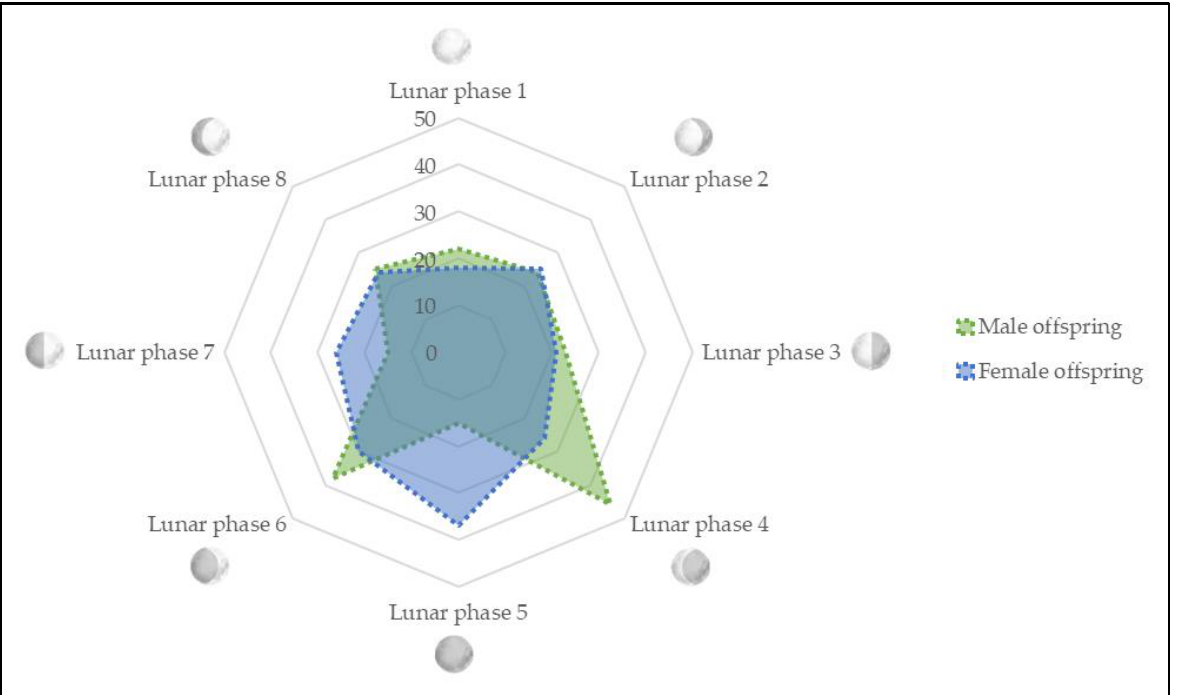
Figure 2. Total number of male and female calves that were born in each lunar phase throughout the whole study period.